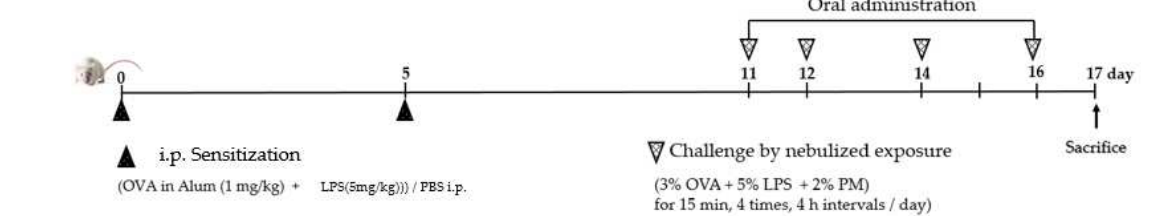
Figure 1. Experimental design for rat model of allergic asthma. SD rats were sensitized with an i.p. injection of OVA-, and LPS- on days 0 and 5 nebulized OVA-, LPS-, and PM were administered by inhalation of nebulized on days 11, 12, 14, and 16. Oral administration, consisting of DEX or each mixture, was performed from day 11 to day 16 of the protocol.